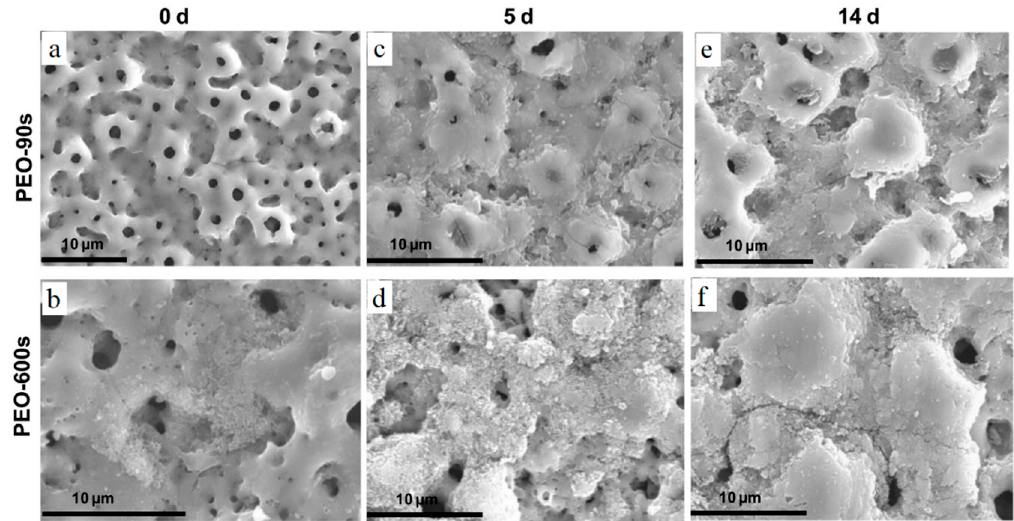
Figure 11. SEM micrographs of MAO-treated Ti CP before and after immersion in α -MEM without cells: ( a ) MAO-90s, ( b ) MAO-600s, ( c ) MAO-90s 5-day immersion, ( d ) MAO-600s 5-day immersion, ( e ) MAO-90s 14-day immersion, ( f ) MAO-600s 14-day immersion [158].